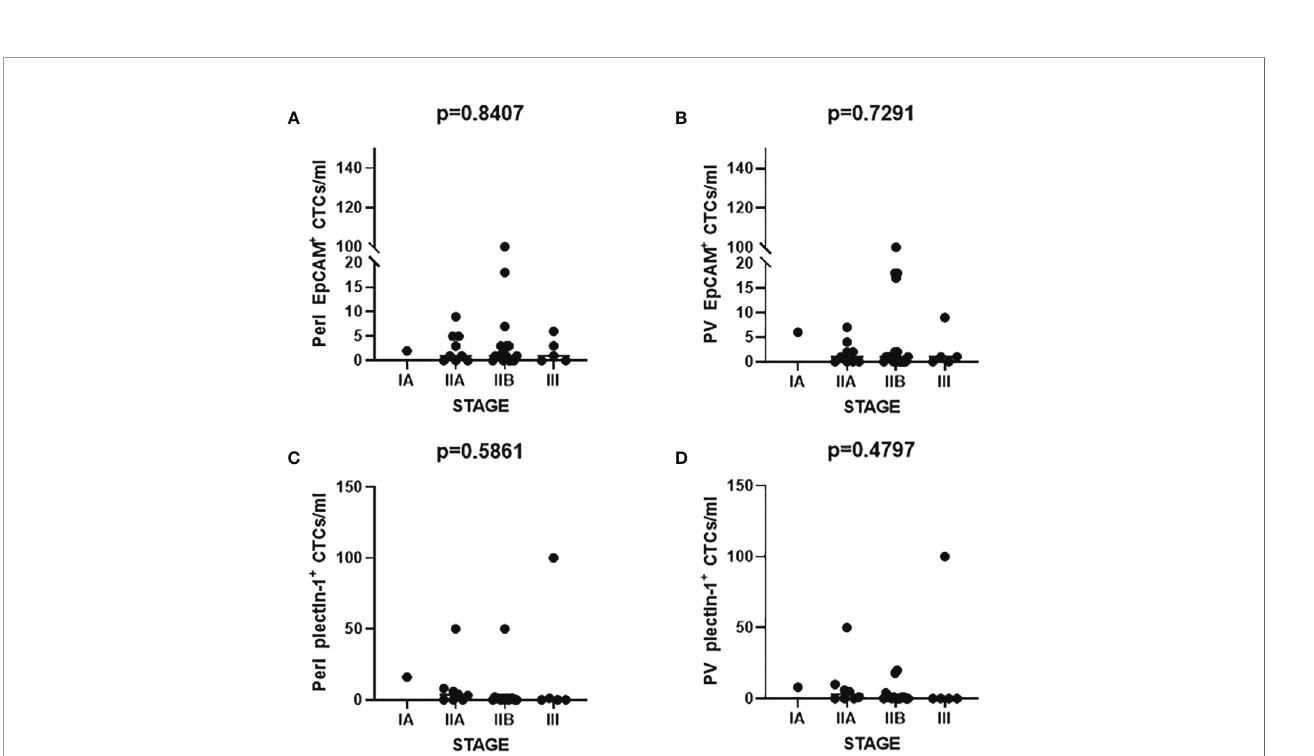
FIGURE 6 | Number of circulating tumor cells (CTCs) according to the American Joint Committee on Cancer (AJCC) staging. The number of CTCs identi fi ed with epithelial cell adhesion molecule (EpCAM) from (A) peripheral vein (Peri) and (B) portal vein (PV) was enumerated. CTCs detected from (C) Peri and (D) PV were counted after Plectin-1 immunostaining. Each count was evaluated according to the AJCC